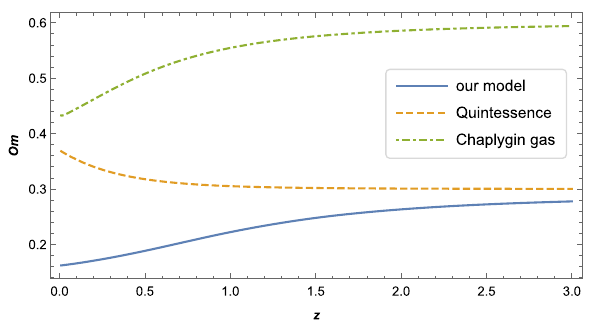
Fig. 6 The evolution of the EOS of the geometric term from f ( T ) modification. The best-fitted parameters given in Table 1 have be used